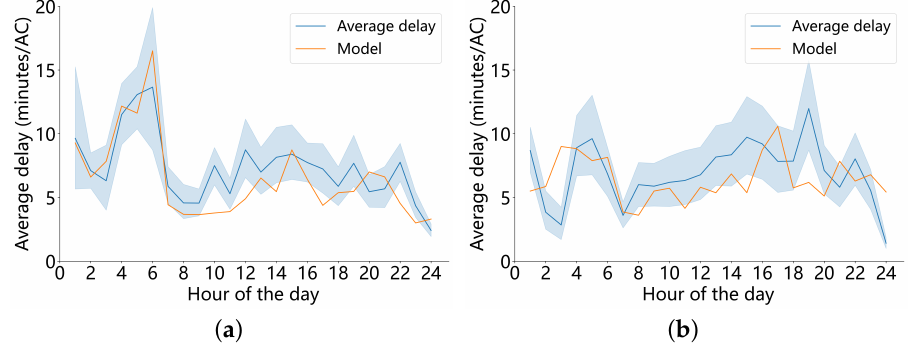
Figure 9. Hourly delay computed from 2-month historical data and simulated data. ( a ) Average hourly delay at ZGGG; ( b ) Average hourly delay at ZGSZ.